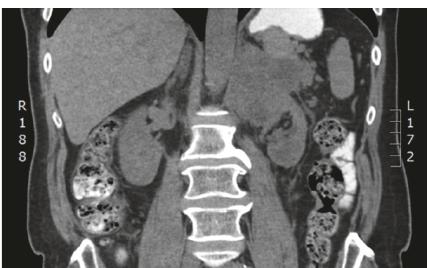
Figure 4: CTabdomen coronal viewshowing a large cystic left renal mass with suspected splenic hilar